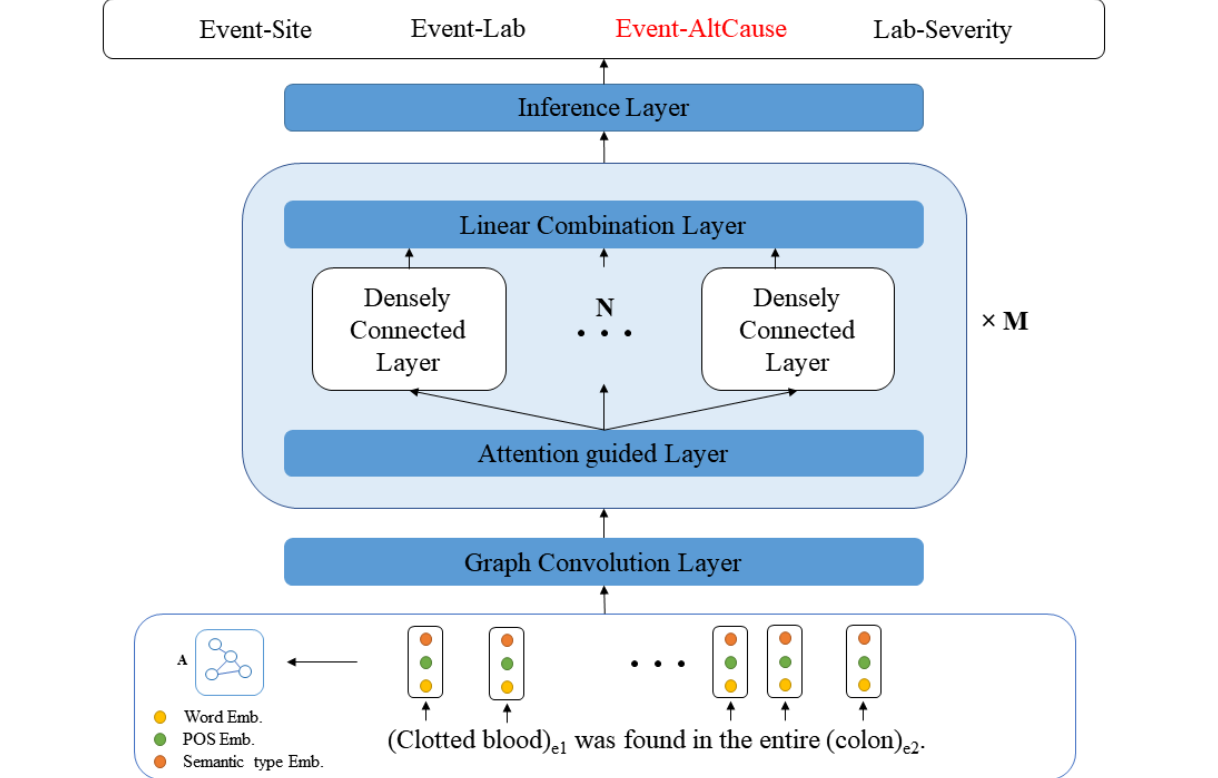
Figure 3. The high-level view of our attention-guided graph convolutional network (AGGCN) model. A is the adjacency matrix used to represent the graph data. The core of the model is comprised of M identical blocks (AGGCN blocks), each with three types of layers as follows: one attention-guided layer, N densely connected layers, and one linear combination layer. Details are available in Multimedia Appendix 1. AltCause: suspected alternative cause; Emb: embedding; POS: parts of